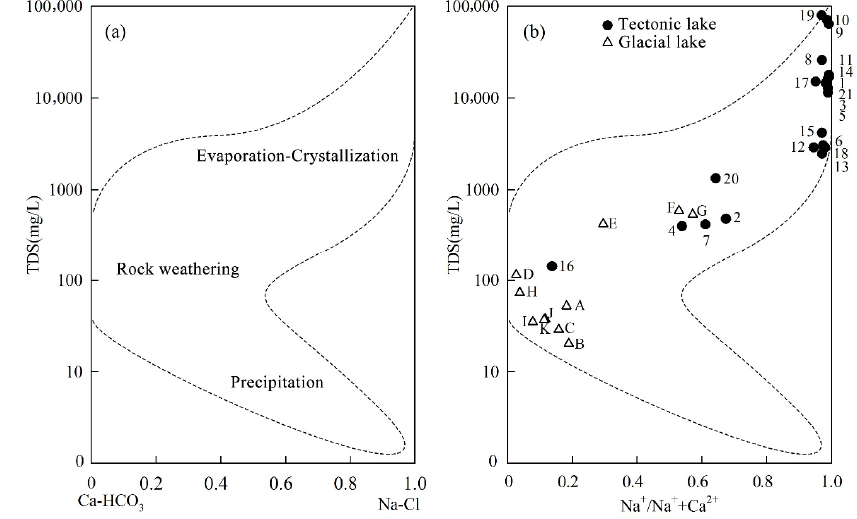
Figure 4. Gibbs distribution patterns ( a ) and the Gibbs diagram of tectonic and glacial lakes of the Tibetan Plateau ( b ). Tibetan Plateau ( b ).